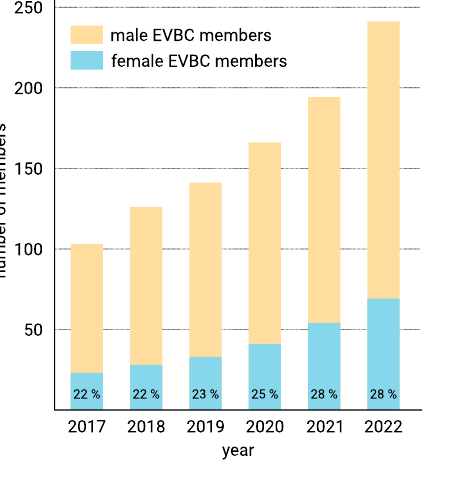
Figure 1. Female scientists in the EVBC. ( Left ) Number of members in the EVBC. Since its foundation, we have succeeded in steadily increasing the proportion of female members. ( Right ) The EVBC seeks to ensure adequate participation of female speakers in lectures and